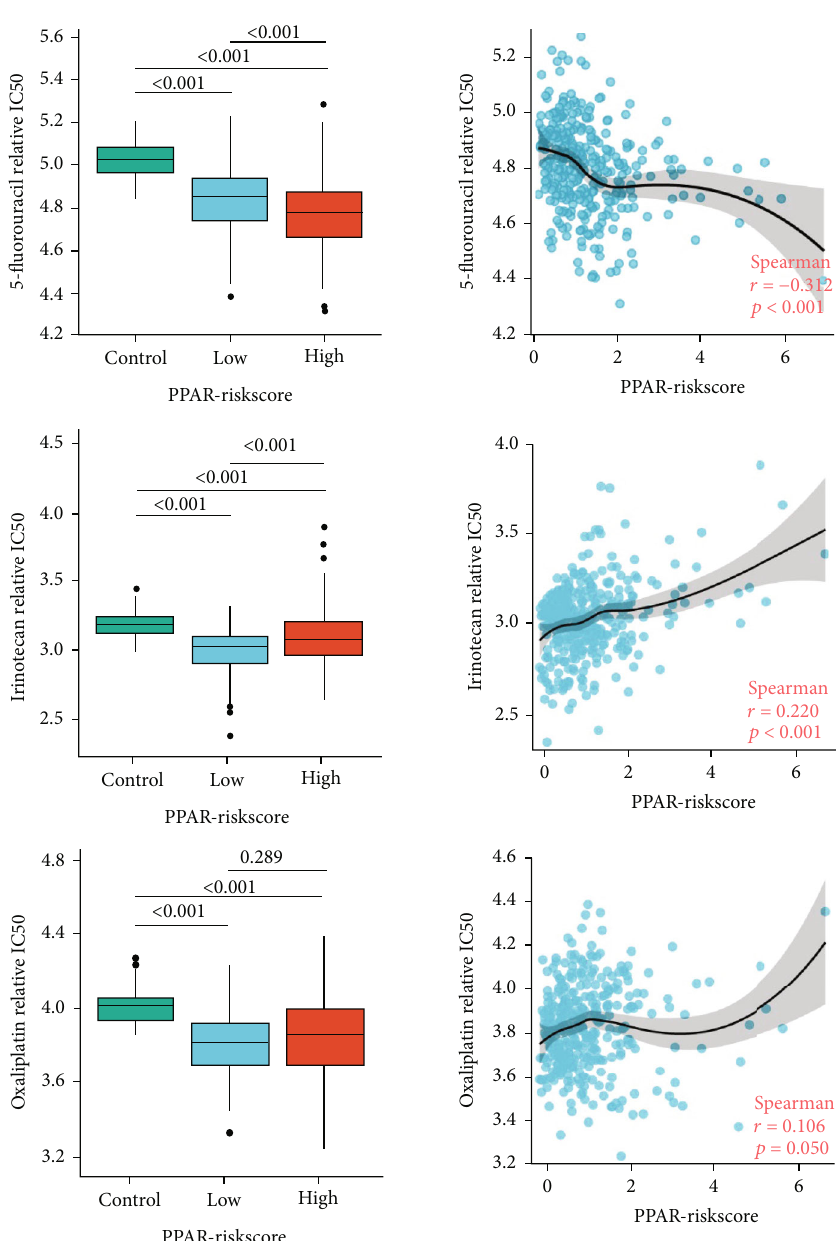
Figure 7: Di ff erences in sensitivity of patients with di ff erent PPAR-Riskscore to chemotherapy. The box plots of the estimated IC50for three commonly used chemotherapy drugs and correlation analysis between IC50 of these drugs and